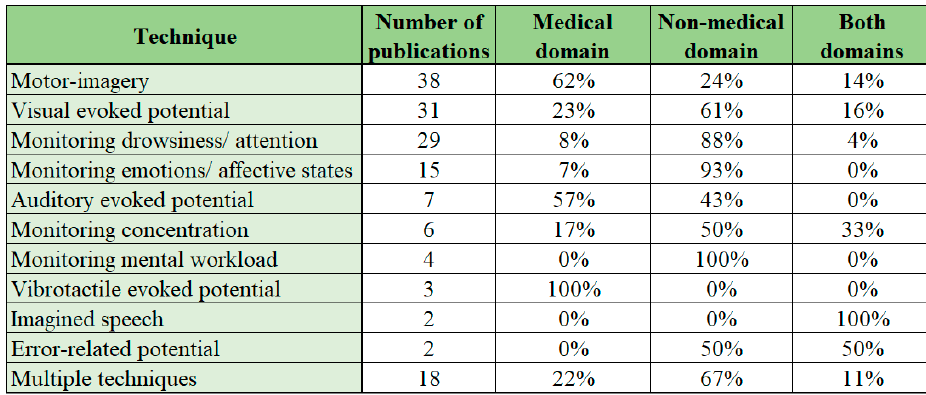
Figure 11. Techniques used in the publications. The techniques have been represented according to the number of publications where the techniques have been used and prevalence among medical, non-medical or both domains.